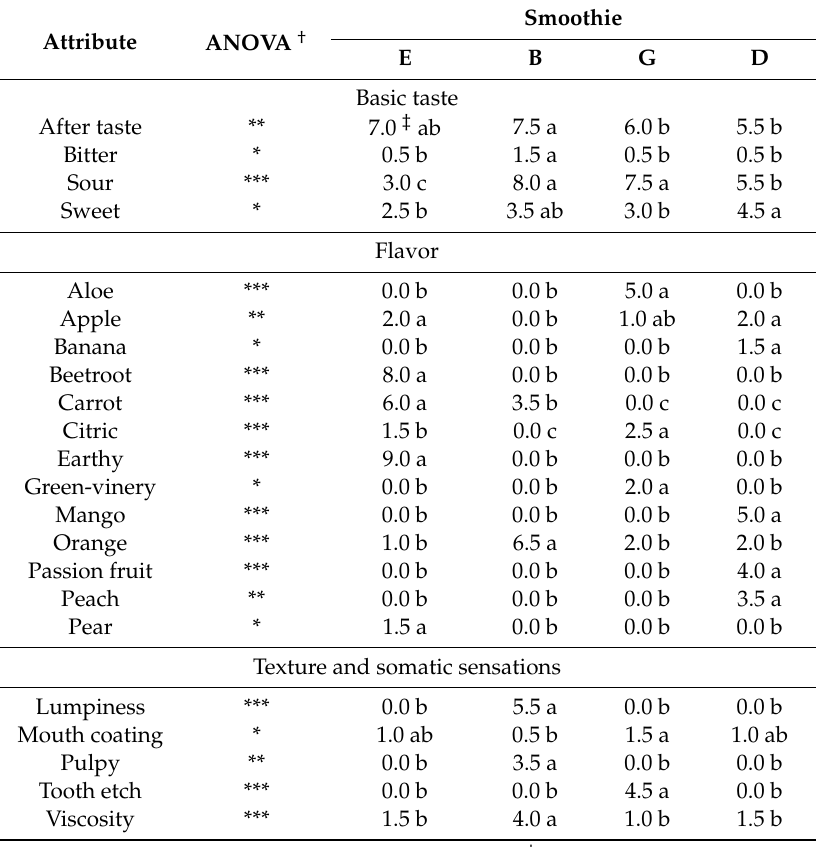
Table 4. Descriptive sensory analysis of the selected commercial smoothies. The scale was range from 0 (no intensity) to 10 (extremely high intensity) with 0.5